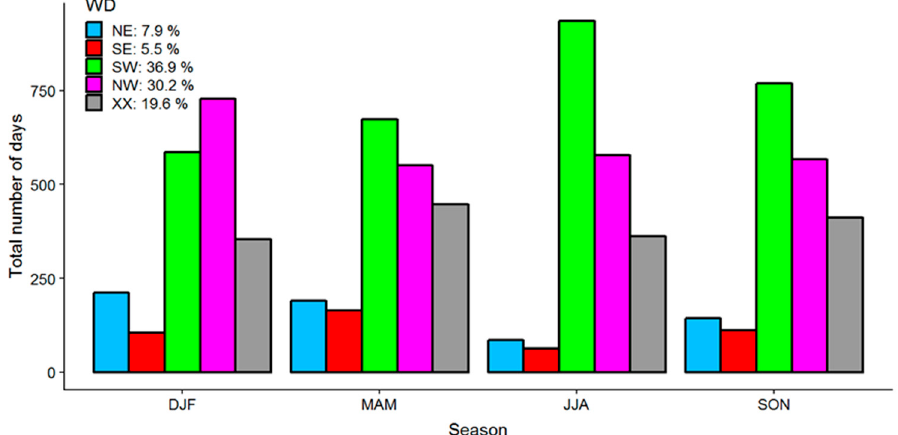
Figure 4. Total number of days per wind direction (WD) class in each season. The numbers in the legend indicate the percentage of days for each WD class for the whole study period, regardless of season. The WD classes are XX: no prevailing direction, NE: northeasterly, SE: southeasterly, SW: southwesterly, and NW: northwesterly. See Section 2.1.